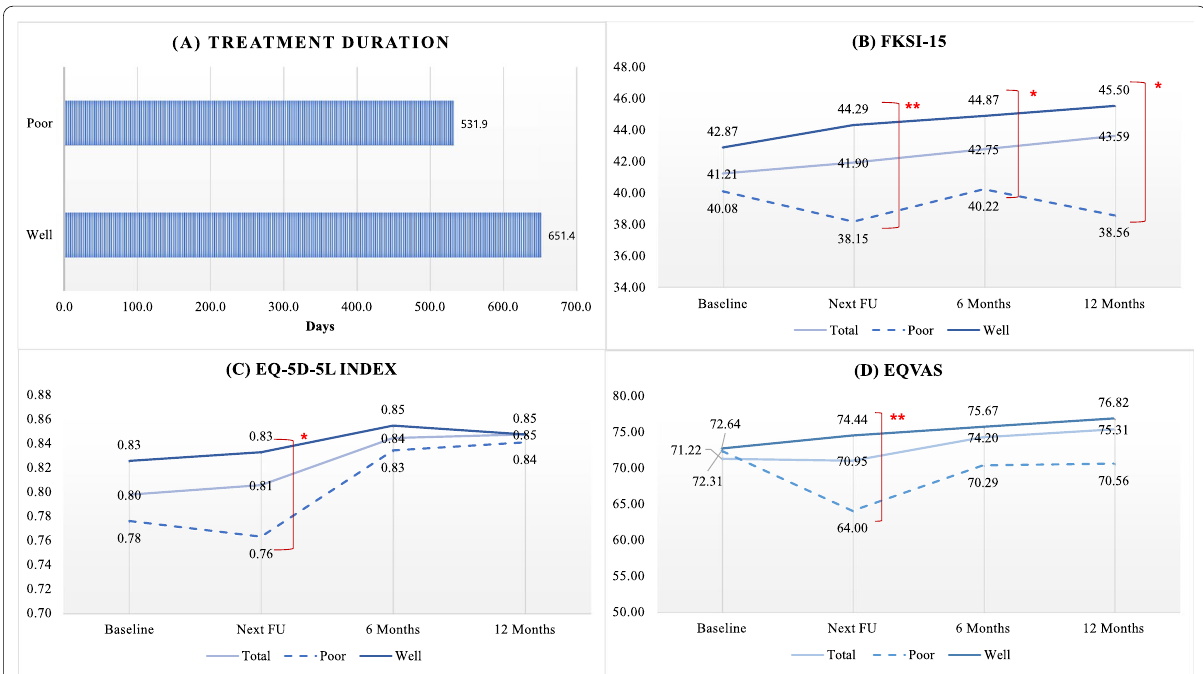
Fig. 2 Univariate analysis comparing outcomes according to patients’ self‑management of adverse events